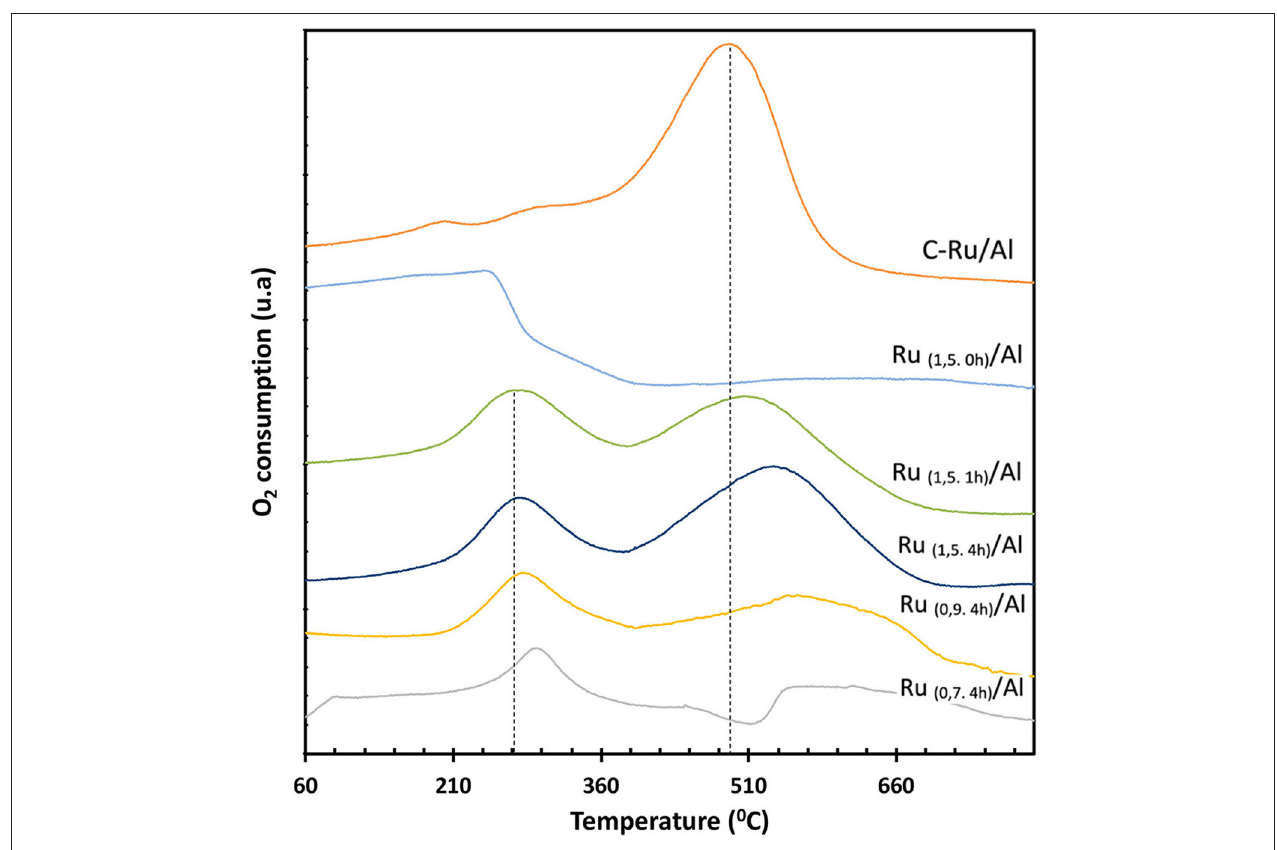
FIGURE 5 | O 2 -TPO profiles for commercial and synthesized Ru/Al solids.